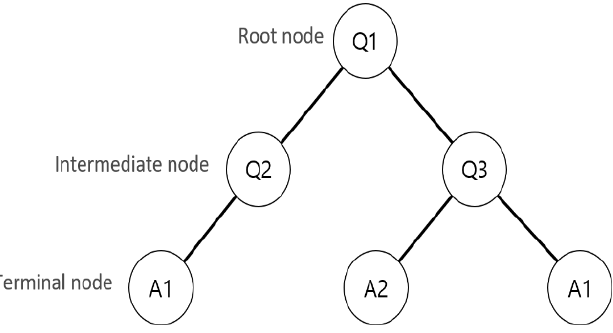
Figure 3. Illustration of a typical DT architecture.